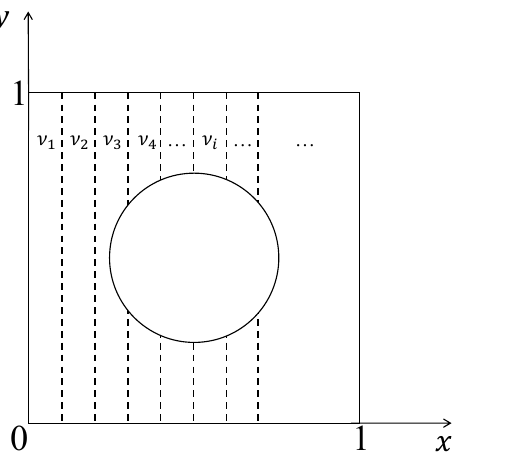
Figure 10. Schematic diagram for 𝜈 (cid:3041) uniformly distributed in the 𝑥 direction. The converged 𝜈 (cid:3041) after inversion is shown in Figure 10. The circle, square, and tri- angle marks represent the results derived from the PINN with the values of 𝑛 set as 5, 10, and 15, respectively. The black line represents the exact solution obtained from Equation (13). Figure 11a depicts the loss versus epoch curve ( n = 10) for a PINN model used to approximate v ( x ) . The curve demonstrates the convergence of the model, indicating that the model learned to fit the training data and approximate v ( x ) accurately. The gradual decrease in loss with increasing epochs suggests that the model was learning and adapting to the problem over time and eventually converged to a stable solution. In general, the converged v n derived from the PINN showed good agreement with the exact solution (shown in Figure 11b), illustrating the capacity of the PINN when used to determine unknown physics laws from a complex non-linear system. As observable in Figure 10, the PINN approach successfully predicted the evolutionary law of the Poisson’s ratio as given by Equation (13), while a maximum discrepancy of only 0.131 was found when n = 15. It can be inferred that n = 10 is the best choice when seeking to solve this problem using a PINN. This is because, when the number of unknown parameters is too small, the v n usually fails to directly reflect the true evolution law. However, when too many parameters are required to be identified at the same time, the calculation accuracy suffers, which may limit the success of identifying the true physics laws.